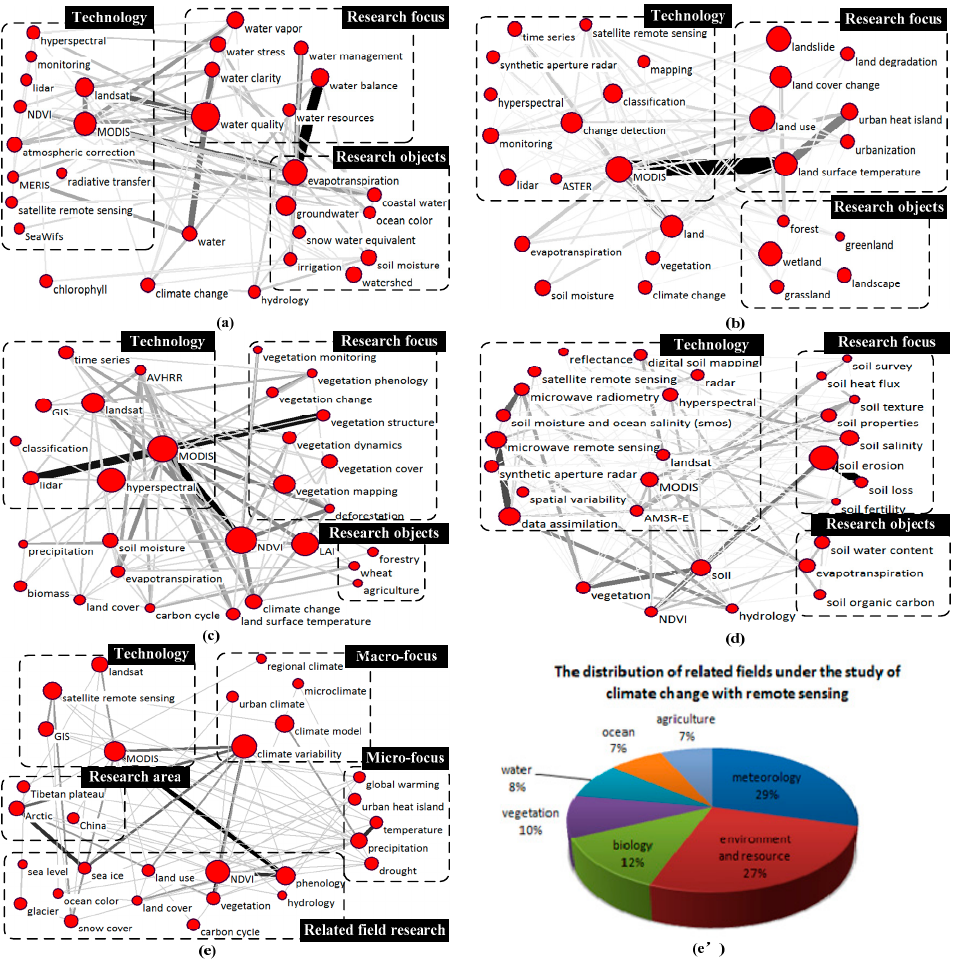
Figure 6. The interconnection network of remote sensing application categories: ( a ) represents the interconnection network of water remote sensing; ( b ) represents the interconnection network of land remote sensing; ( c ) represents the interconnection network of vegetation remote sensing; ( d ) represents the interconnection network of soil remote sensing; ( e ) represents the interconnection network of climate remote sensing; ( e’ ) represents the distribution of related fields under the category of climate remote sensing.